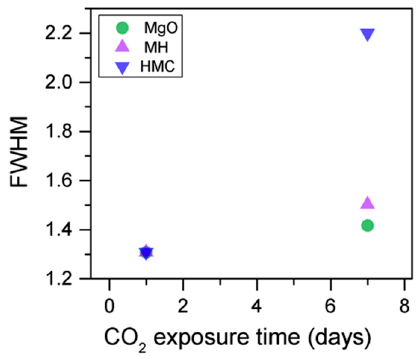
Figure 16. O1s FWHM for samples exposed to 10% CO 2 for one and seven days.